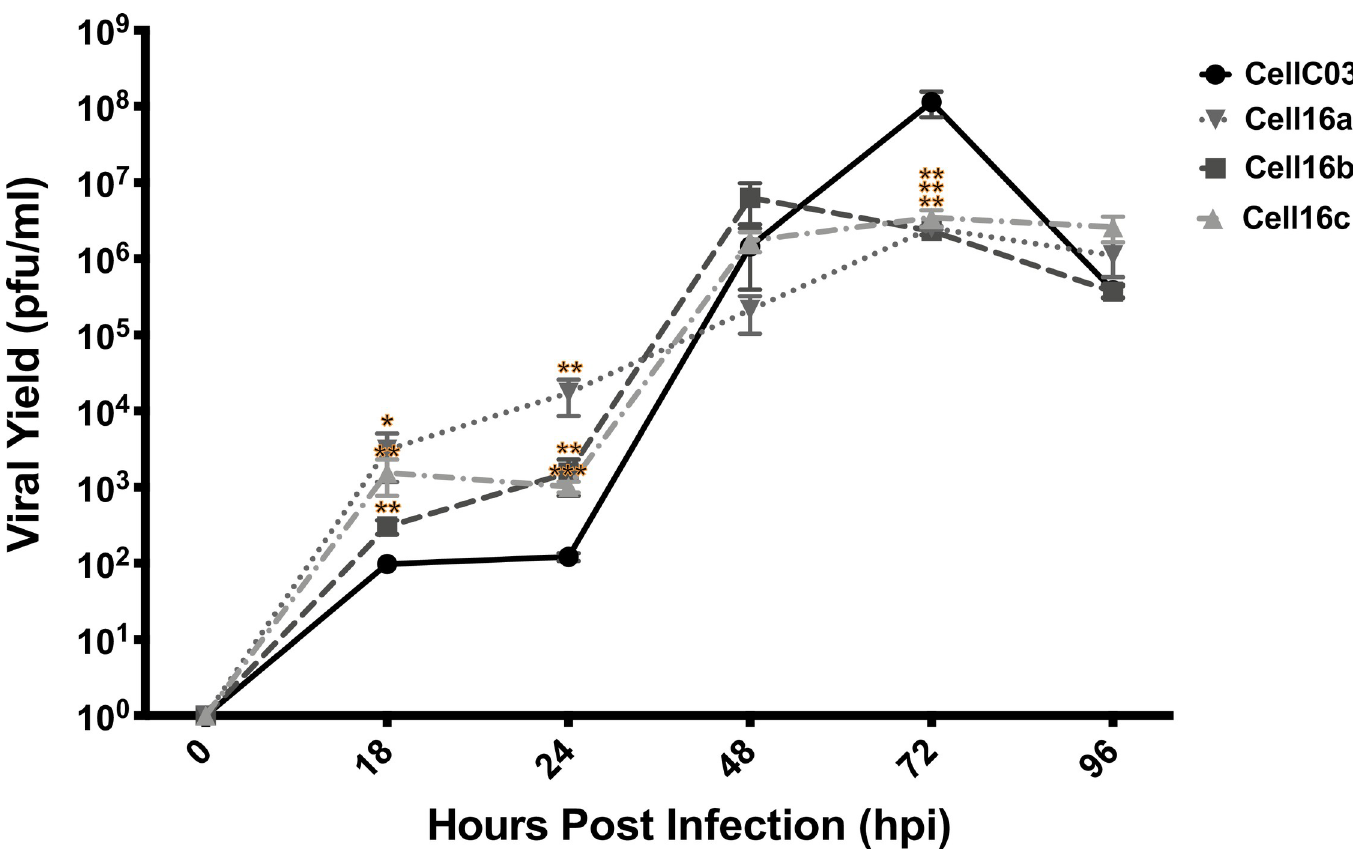
Fig 6. Viral yield assay comparison of infectious viral particles produced (pfu/ml) in wild type (CellC03) and three 2016 VHSV-IVb samples, in BF2 cells 96 hpi, following exposure to media from collection time post infection. Standard error bars are representative of at least three independent experimental replicates. Statistical significance is shown: � p < 0.05; �� p < 0.01; ��� p <